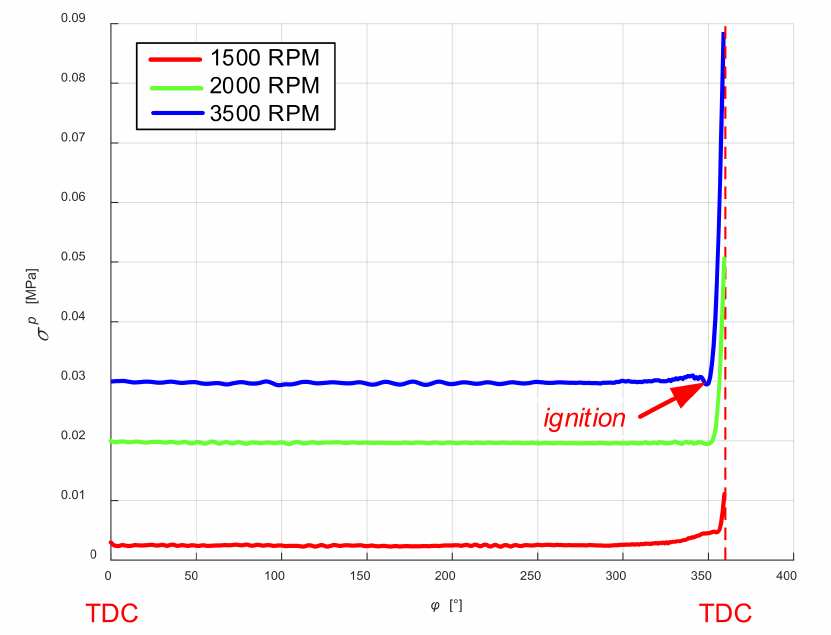
Figure 2. Comparison of the values of standard deviations for the waveforms from Figure 1 and for measurements with the rotational speed of 1500 and 2000 rpm, determined in the range of the angle of rotation from 0 ◦ to 360 ◦